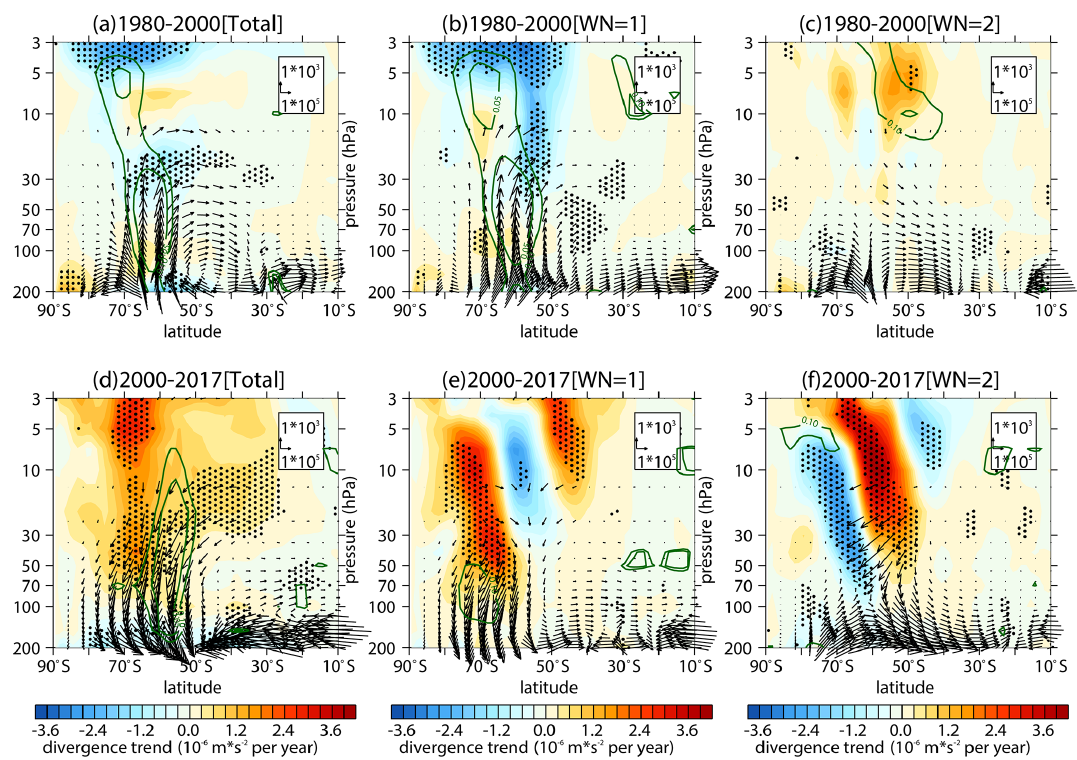
Figure 1. Trends in the Southern Hemisphere (a, d) stratospheric E–P flux (arrows; units of horizontal and vertical components are 10 5 and 10 3 kgs − 2 yr − 1 , respectively) and its divergence (shading) with their (b, e) wave 1 components and (c, f) wave 2 components over (a, b, c) 1980–2000 and (d, e, f) 2000–2017 in September, as derived from the MERRA-2 dataset. The stippled regions indicate the trend of the E–P flux divergence significant at/above the 90% confidence level. The green contours from outside to inside (corresponding to p = 0.1 and 0.05) indicate the trend of vertical E–P flux significant at the 90% and 95% confidence level, respectively. Table 3. Correlations of stratospheric vertical wave flux time series (area weighted from 100 to 30hPa over 70–50 ◦ S) between different reanalysis